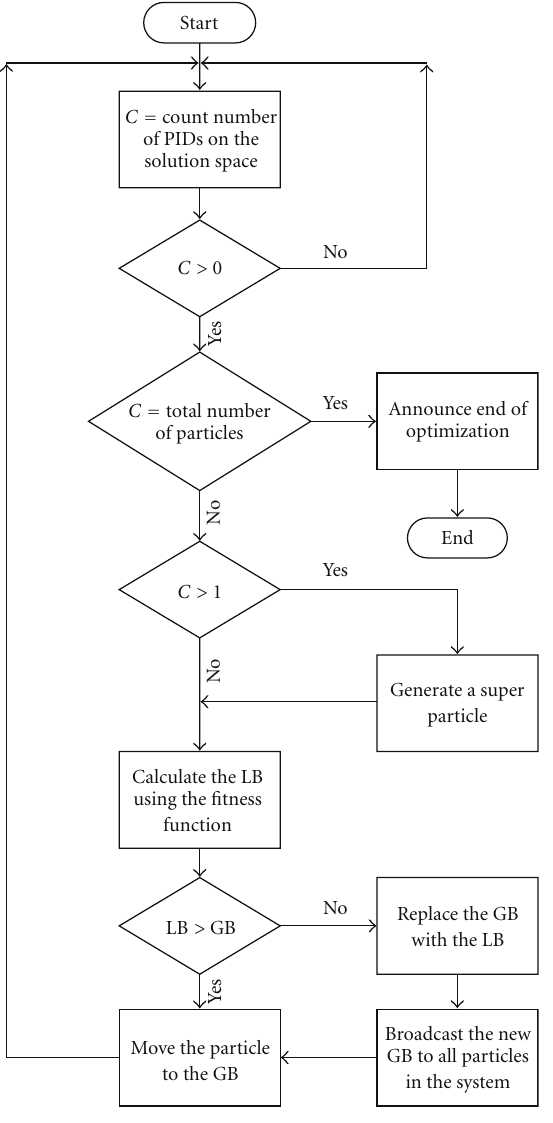
Figure 7: Flowchart of the TPSO algorithm for ad hoc network.